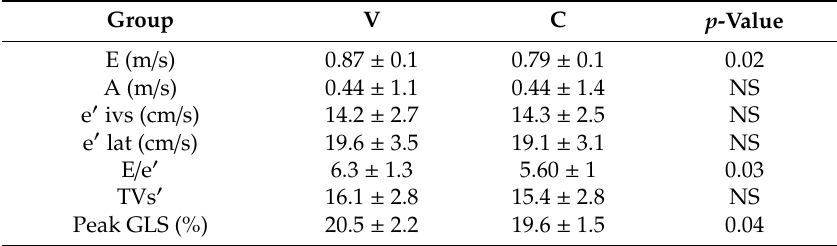
Table 4. Systolic and diastolic echocardiographic